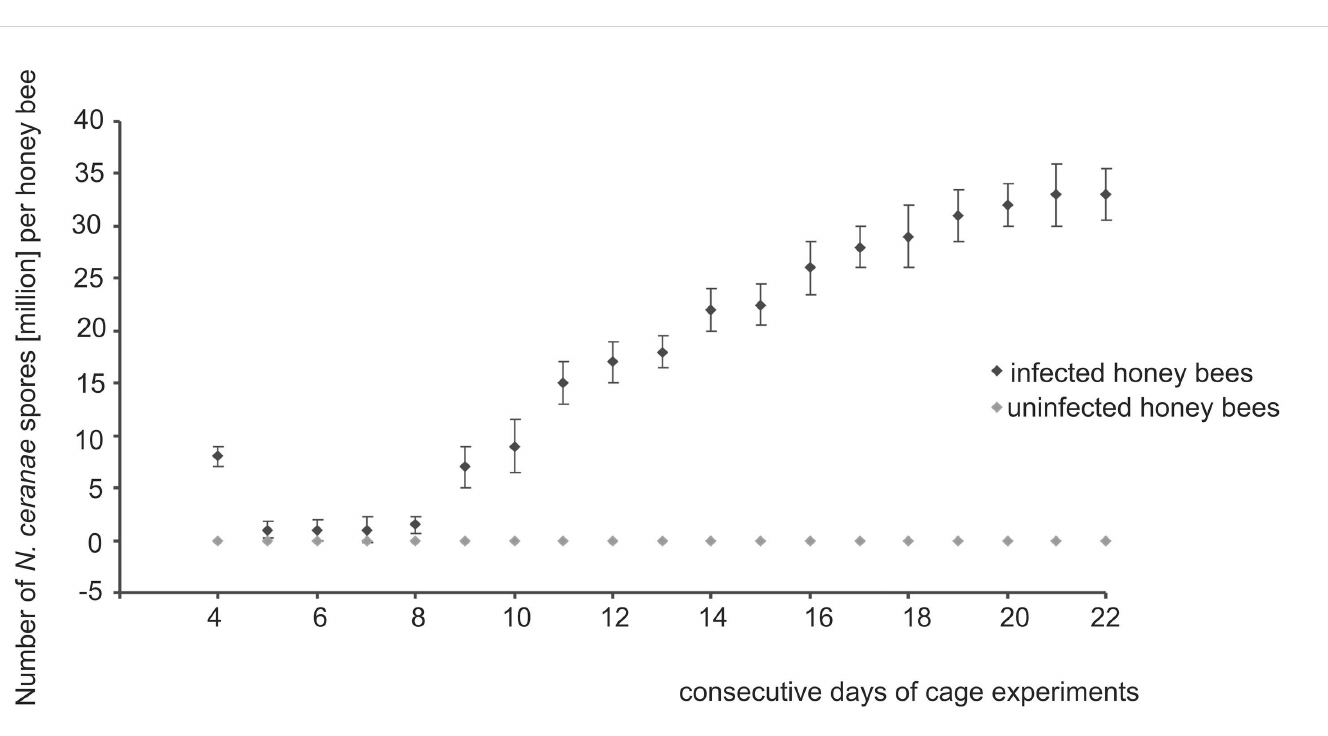
Fig 3. Cage tests. The average N . ceranae infection intensity observed during consecutive days of cage experiments conducted in 2014 and 2015. Data obtained from daily samplingfrom the second day after the infection (4-day-oldworkers) to the end of each experimentin 2014 and 2015. Diamondshapes ( ♦ ) represent means while error bars indicate standard